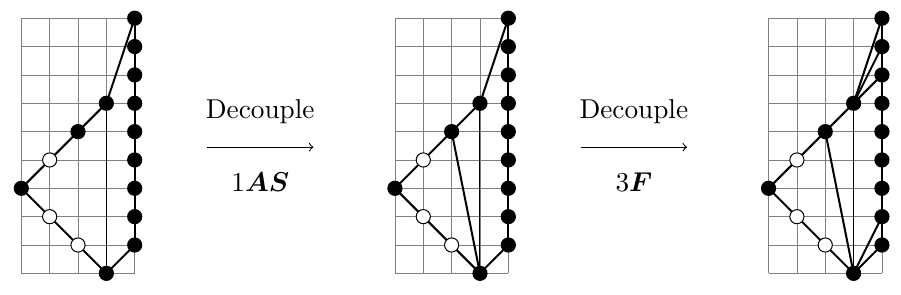
Figure 3 . Example of decoupling matter. We start from SU(2 n ) n +1 AS +8 F and after decoupling an anti-symmetric we obtain SU(2 n ) positive and two with negative mass) to reach SU(2 n )